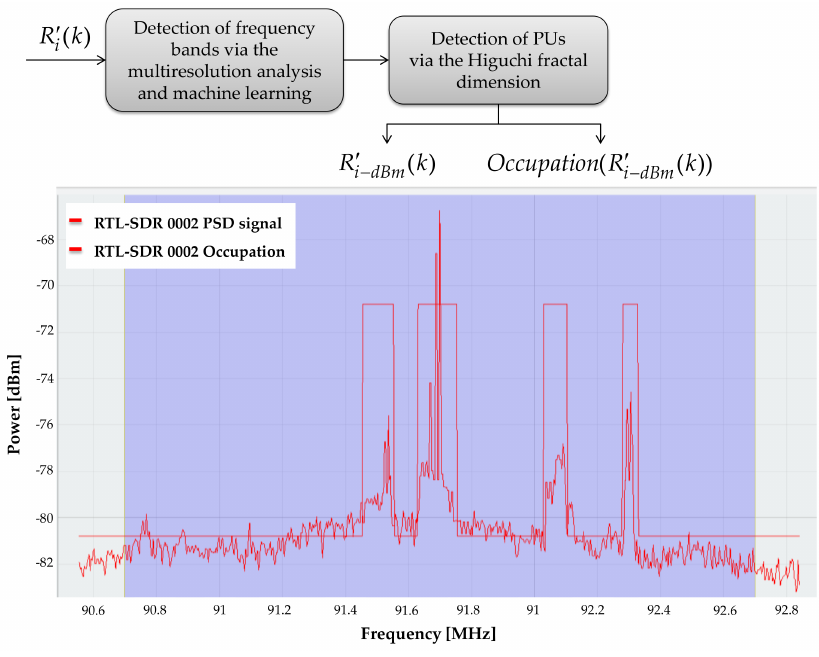
Figure 14. Delivered signals from the “detection of primary users” block.